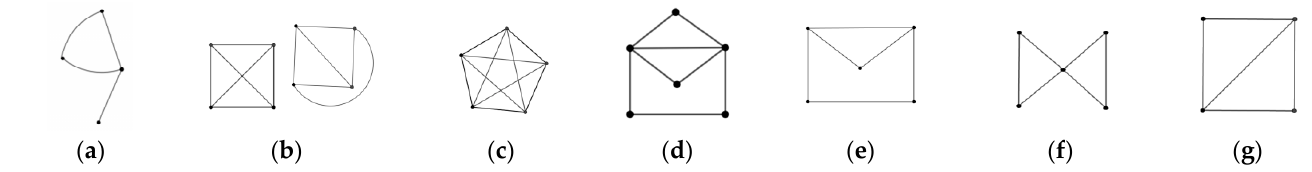
Figure 1. Basic graphs. Examples of ( a ) graph; ( b ) planar graph; ( c ) nonplanar graph; ( d ) Eulerian graph; ( e ) non-Eulerian graph; ( f ) Eulerian graph, but non-Hamiltonian graph; ( g ) Hamiltonian graph, non-Eulerian graph.